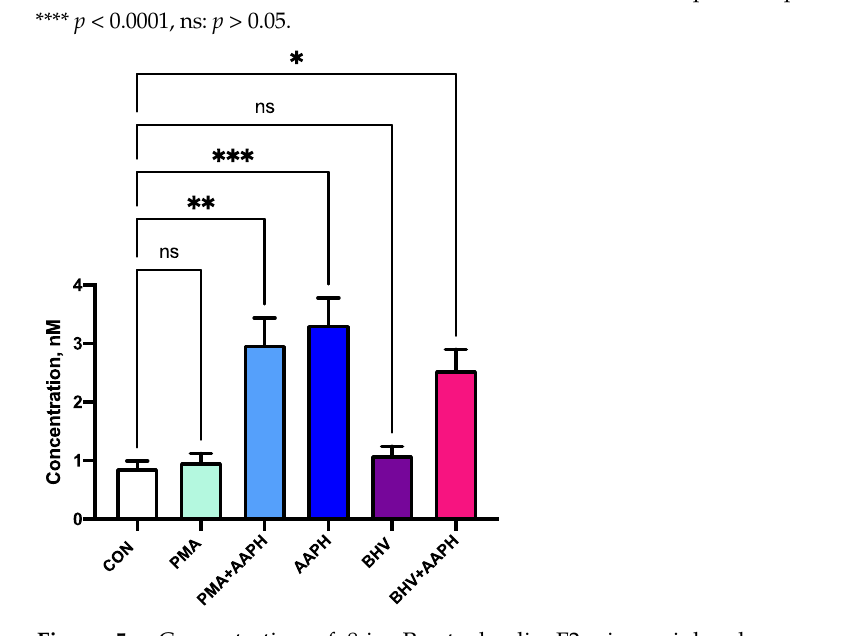
Figure 5. Concentration of 8-iso-Prostaglandin F2 α in peripheral mononuclear blood cells (PBMCs) culture supernatant. Results are expressed as geometric estimated means ± SEM. CON = Untreated PBMCs; PMA = PBMCs treated with 10 ng/mL phorbol 12-myristate 13-acetate (PMA) and 1 μ g/mL ionomycin; PMA + AAPH = PBMCs treated with 10 ng/mL PMA, 1 μ g/mL ionomycin, and 3 mM of 2,2 ′ -Azobis(2-amidinopropane) dihydrochloride (AAPH); AAPH = PBMCs treated with 3 mM AAPH; BHV = PBMCs treated 8 × 10 4 TCID 50 Bovine Herpesvirus 1 per 1 × 10 6 PBMCs; BHV + AAPH = PBMCs treated 8 × 10 4 TCID 50 Bovine Herpesvirus 1 per 1 × 10 6 PBMCs and 3 mM AAPH. Differences between treatments and the control were assessed with Dunnett’s pairwise post hoc test * p < 0.05, ** p < 0.01, *** p < 0.001.